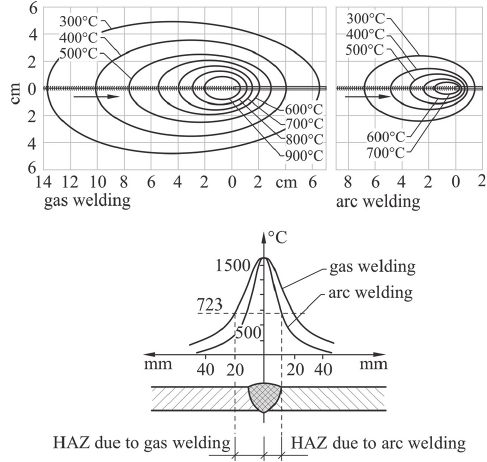
Fig. 2. Temperature distribution during the welding (Pasquale 2001)